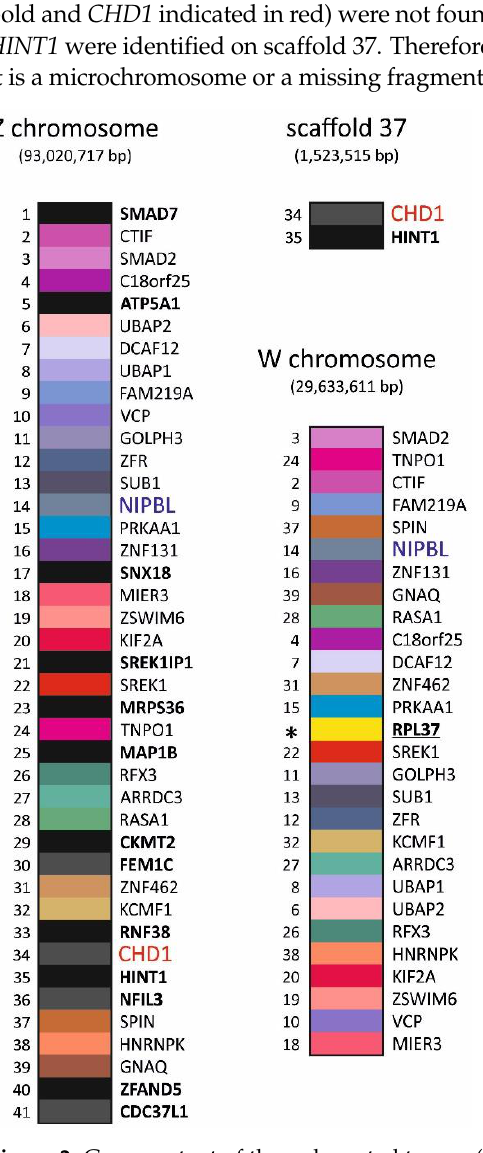
Figure 2. Gene content of the red-crested turaco ( T. erythrolophus ) Z chromosome, W chromosome and nuclear scaffold 37. The names of genes identified on the Z chromosome that do not have their counterparts on the W chromosome are marked in bold. The name of a gene identified on the W chromosome that has no counterpart on the Z chromosome is underlined. Its position on the W chromosome is marked with an asterisk (*). On the W chromosome and Scaffold 37, the gene numbering was retained to correspond to the position of their counterparts on the Z chromosome.